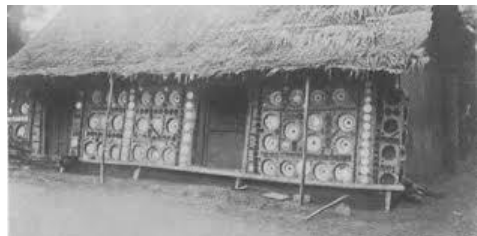
Figure 17. A decorated wall surface Source: